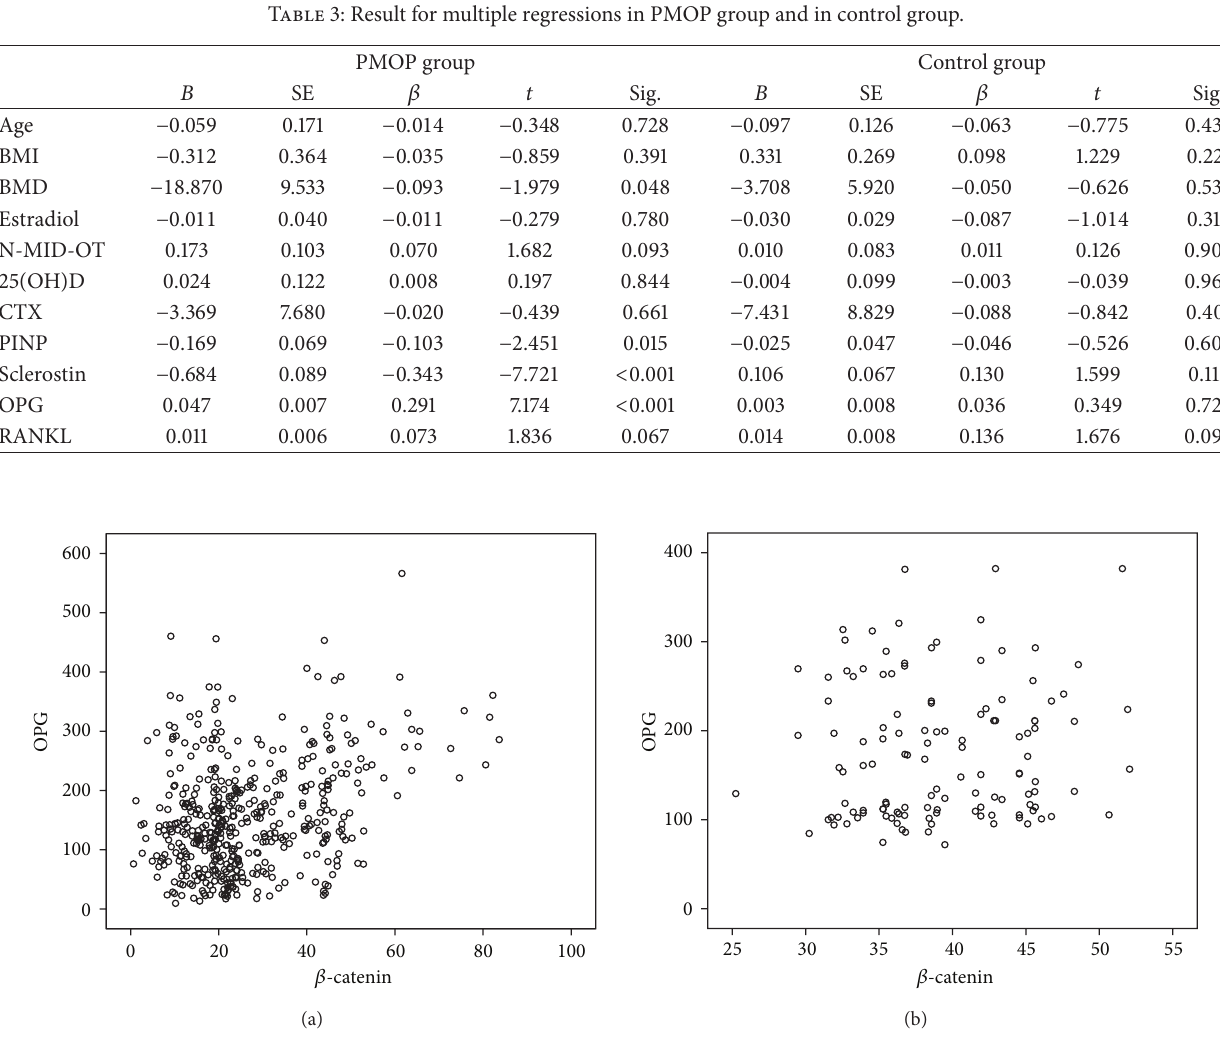
Figure 1: Univariate correlation (Spearman analysis) between 𝛽 -catenin and OPG serum levels in PMOP patients ((a) 𝑟 = 0.232 , 𝑃 < 0.001 ) and controls ((b) 𝑟 = 0.112 , 𝑃 = 0.145